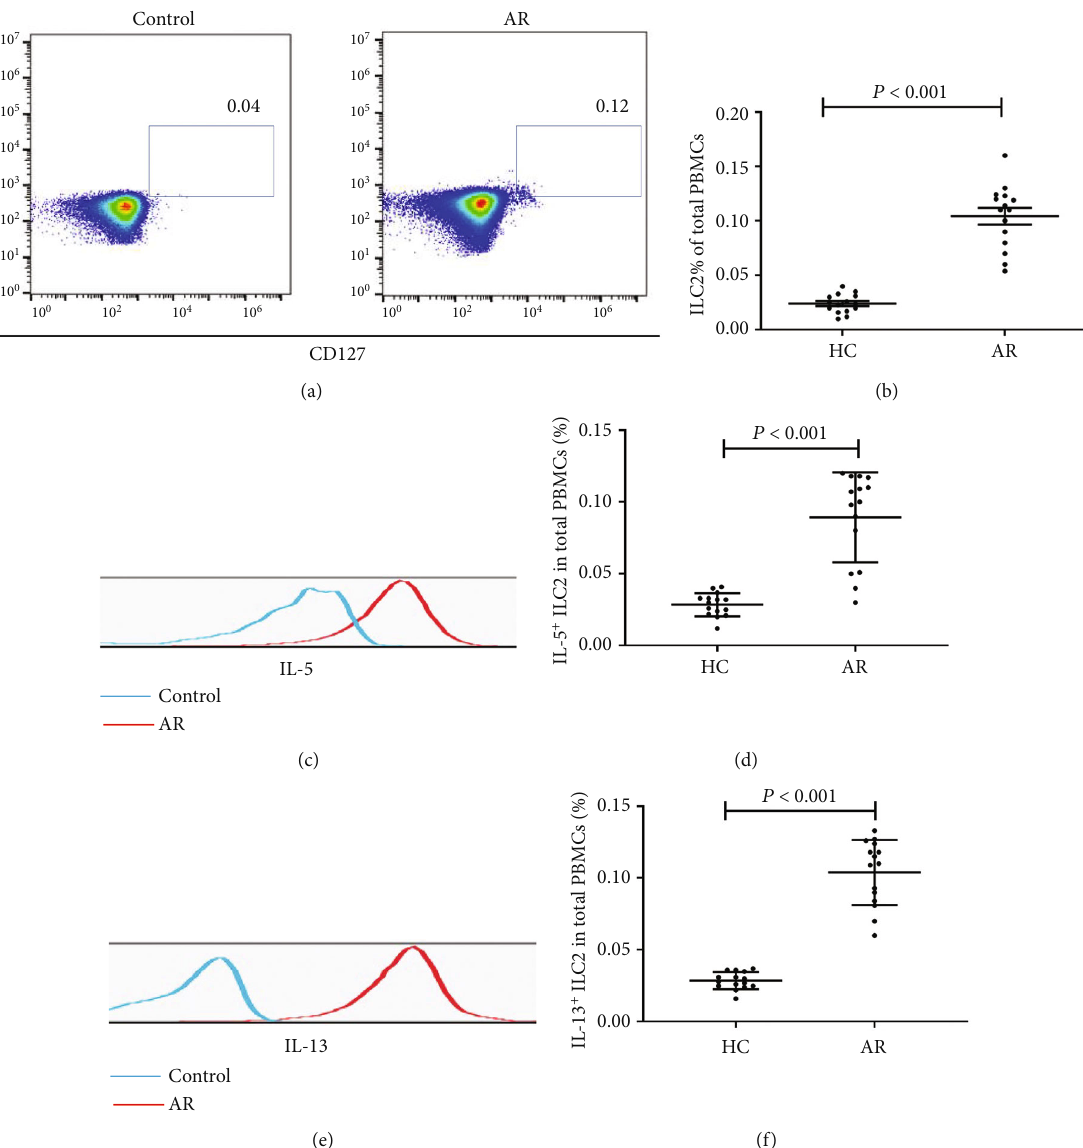
Figure 1: The frequency of ILC2, IL-5+ILC2, and IL-13+ILC2 cells between AR patients and controls. (a, c, e) Flow cytometric results of the proportion of ILC2, IL-5+ILC2, and IL-13+ILC2 cells between HC and AR. (b, d, f). The proportions of ILC2, IL-5+ILC2, and IL-13+ILC2 between HC and AR were detected by fl ow cytometry. AR: allergic rhinitis; HC: healthy control; ILC2: type 2 innate lymphoid